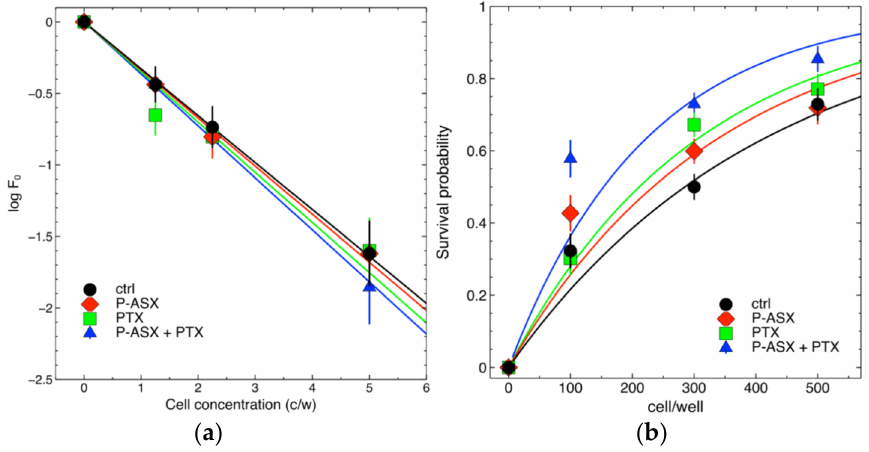
Figure 6. Effects of PTX and ASX microparticles on irradiated J774A.1 macrophages. ( a ) Limiting dilution assays were performed with non-irradiated cells to estimate parameter ε in Equation (1) (see the main text for details). Cells were seeded at each indicated density into the wells of 96-well culture plates and treated with ASX microparticles (P-ASX) and PTX, either alone or in combination (P-ASX + PTX), or left untreated (ctrl). F 0 is the fraction of cells where no proliferation was observed at the end of the observation period (~30 days). When the cells are randomly and independently distributed, F 0 is expected to obey Poisson statistics with parameter ε . Linear fitting of log-transformed data provided the following estimates: ε ctrl = 0.328 ± 0.0325, ε P-ASX = 0.336 ± 0.036, ε PTX = 0.351 ± 0.036, ε P-ASX+PTX = 0.364 ± 0.038. The differences in the estimated parameter values were not statistically significant (ANOVA test, p = 0.9). ( b ) Survival probability of independent cell populations treated with ASX microparticles (P-ASX), PTX, P-ASX in combination with PTX (P-ASX + PTX) or left untreated (ctrl) and then irradiated with a dose of 4 Gy γ -rays. Nonlinear fits with Equation (1) allowed to estimate the fraction of the cells surviving radiation treatments (see also the main text for details). The results are: S ( D ) ctrl = 0.0071 ± 0.0005 ( χ 2 /df = 1.5), S ( D ) P-ASX = 0.0086 ± 0.0006 ( χ 2 /df = 1.2), S ( D ) PTX = 0.0095 ± 0.0007 ( χ 2 /df = 1.7), S ( D ) P-ASX+PTX = 0.0131 ± 0.001 ( χ 2 /df = 2.1). All observed